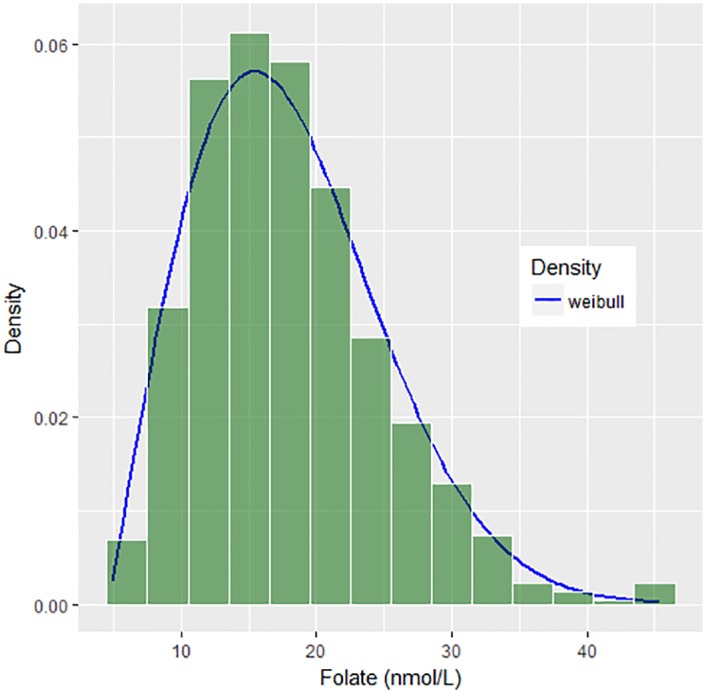
Histogram with density curve for folate.